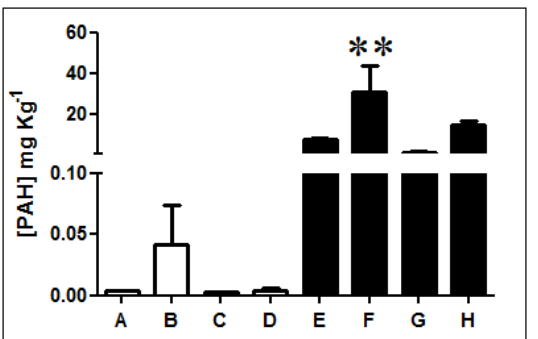
Figure 1. Quantification of three-ring PAHs in Antarctic soil samples. The concentration of three-rings PAHs was determined in non-exposed (white bars; A, B, C, and D) and diesel-exposed soil samples (black bars; E, F, G, and H). ** Represents significance with a p < 0.05.